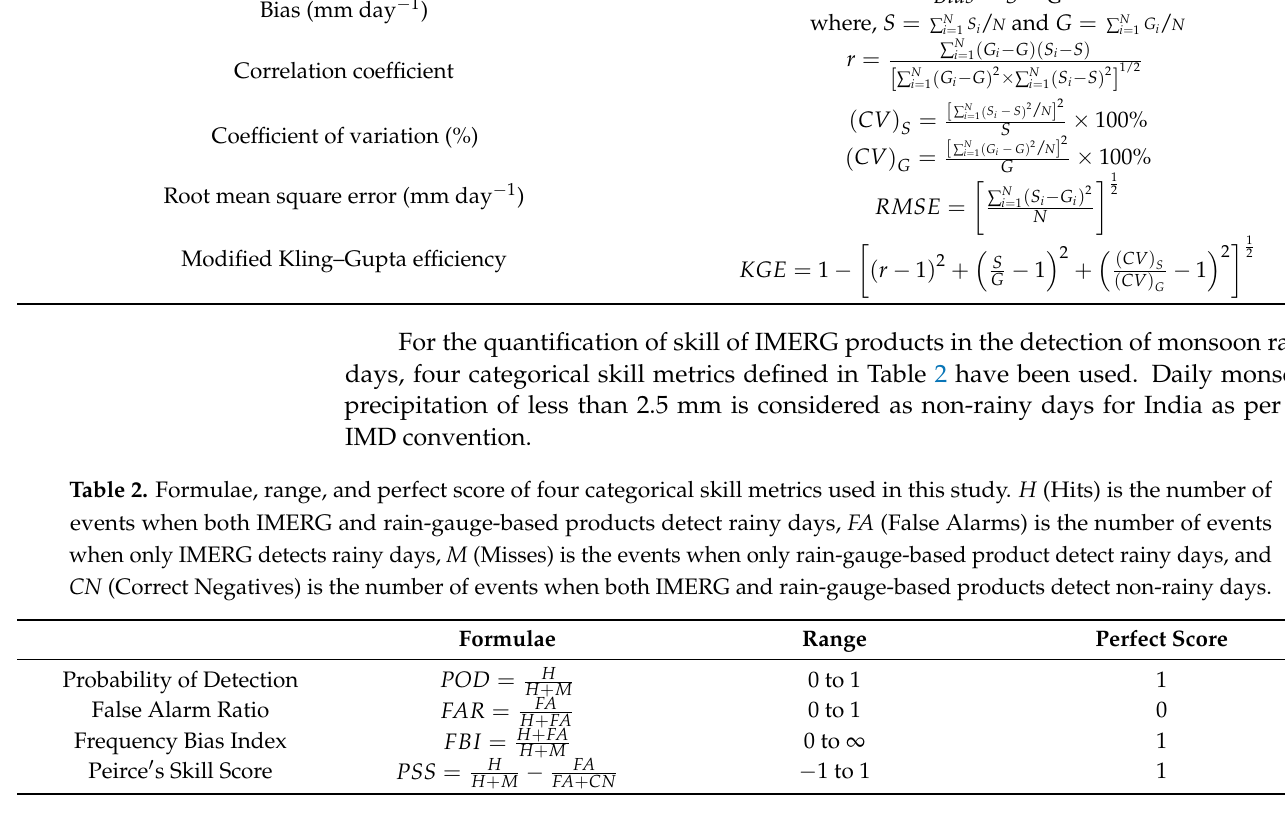
Table 1. Formulae for the computation of continuous error metrics used in this study. S i and G i denote precipitation estimates from the IMERG and rain-gauge-based products, respectively, and N is the total number of colocated points. Error Metrics Formulae Bias (mm day − 1 ) Correlation coefficient